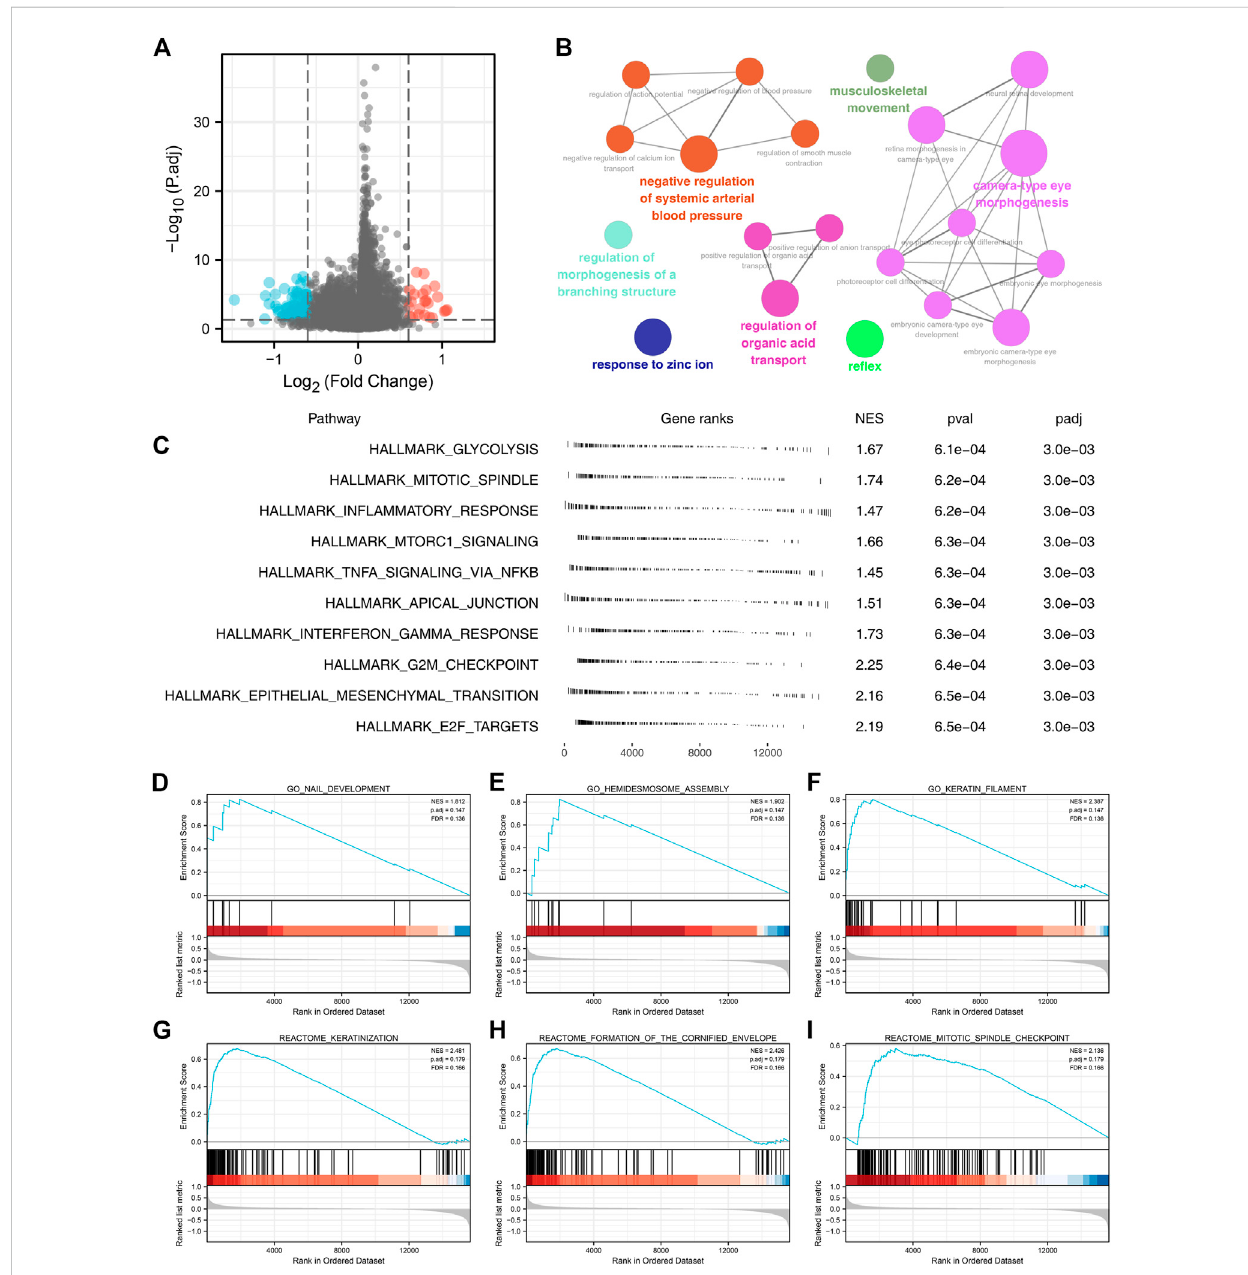
FIGURE 3 Biological investigation of FADD in lung cancer. Notes: (A) DEGs analysis of high- and low-FADD patients; (B) ClueGO analysis; (C) GSEA analysis of FADD; ( D-F) : GSEA analysis based on GO gene set; ( G-I) : GSEA analysis based on REACTOME gene set.